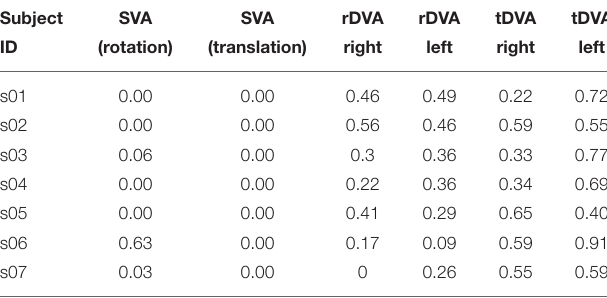
TABLE 1 | SVA, rDVA, and tDVA